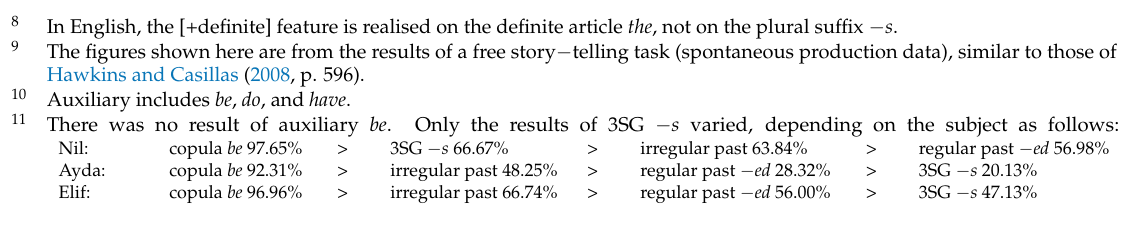
Table 4. Previous L2 English studies (naturalistic spoken data).